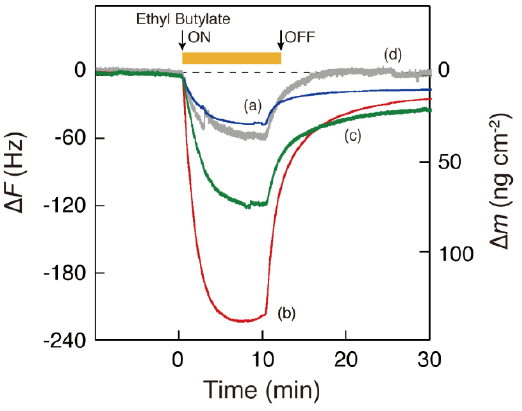
Figure 4. Time courses of the frequency change ( Δ F ) for QCM plates modified with (a) α‐ , (b) β‐ , and (c) γ‐ CD films, and (d) the pentaerythritol film, in response to a flow of 0.66 mmol L − 1 vaporized ethyl butyrate in dry air at a flow rate of 0.1 L min − 1 for 10 min, indicated by the orange bar at 25 °C.